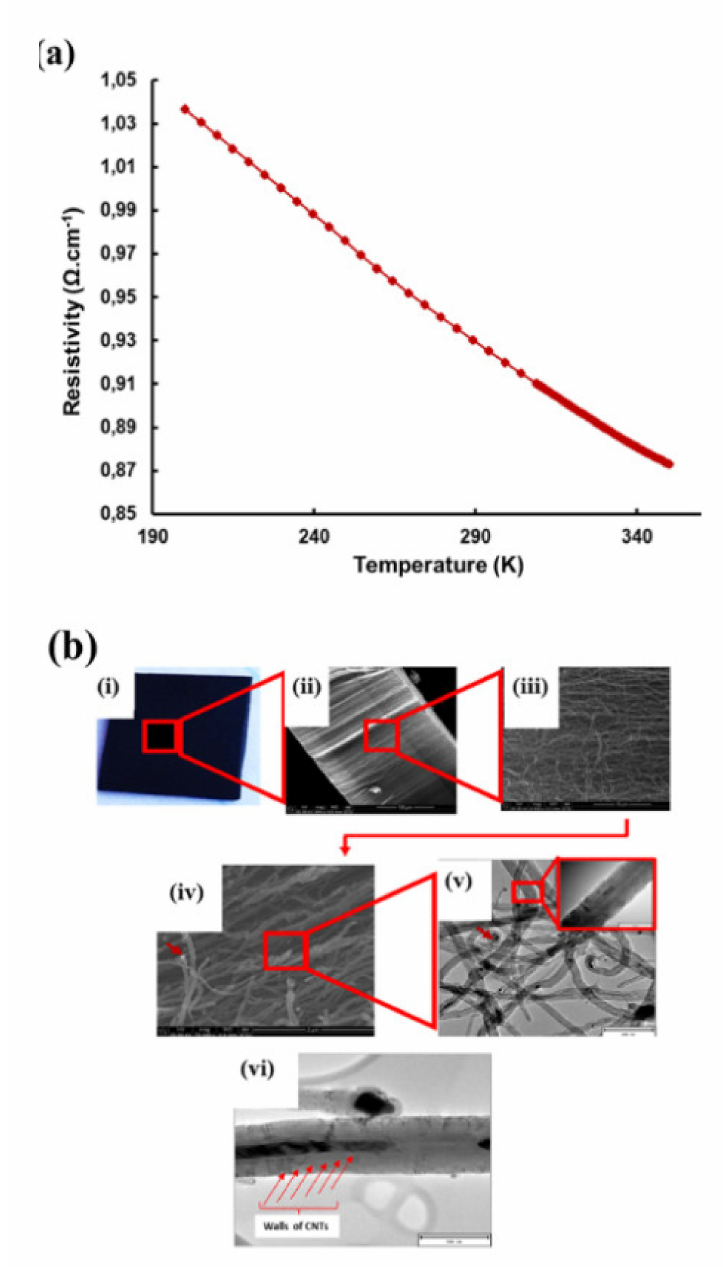
Figure 7. CNT electrical properties and MWCNTs from silicon wafer. Electrical resistivity of VA-MWNTs from 200 to 350 K ( a ). MWCNTS deposited on Si wafer ( b (i)), SEM micrograph of CNTs at 844 × magnification ( b (ii)), SEM micrograph of CNTs at 8430 × magnification ( b (iii)), SEM micrograph of CNTs at 70,399 × magnification ( b )(iv) and TEM micrograph of CNTs with insert at very high magnification ( b (v)). TEM micrograph of the MWCNT with red arrows indicating the location of the walls ( b